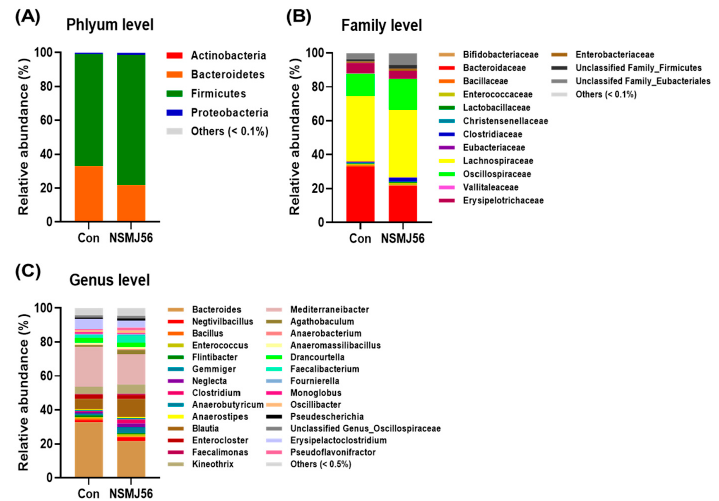
Figure 7. Distribution of the predominant phyla, families, and genera in the microbiome of broiler caeca. Broilers were fed with either a control diet or NSMJ56-containing diet for 10 days. 16S rRNA sequencing was conducted to determine the relative abundance at the phylum level ( A ), family level ( B ), and genus level ( C ). Proportions of the microbiome represented by less than 0.1% (phylum and family level) and less than 0.5% (genus level) were classified as “Others.”